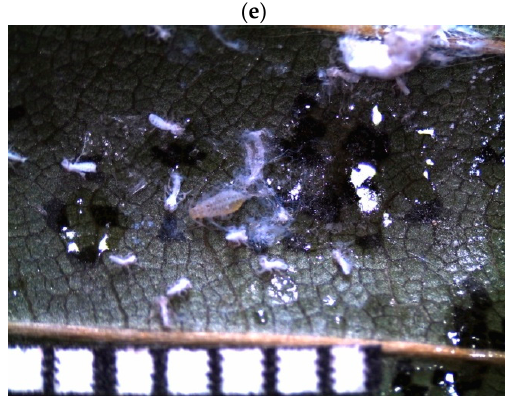
Figure A1. Feeding traces (Recognizable Taxonomic Units) of leaf-chewers and sap-suckers (exophagous feeding guilds) on Fagus sylvatica leaves. ( a ) Windows (probably Diurnea flagella , ADS); ( b ) small circles (probably Orchestes fagi , ADS); ( c ) labyrinth (probably Phyllobius argentatus , ADS); ( d ) whitish spots (probably Fagocyba cruenta, ADS); ( e ) wax wool (probably Phyllaphis fagi , ABS). Images were taken with an integrated digital camera of a stereo microscope (LEICA EZ4 D, Wetzlar, Germany). Little square equals 1×1 mm, ADS = adaxial side, ABS = abaxial side.